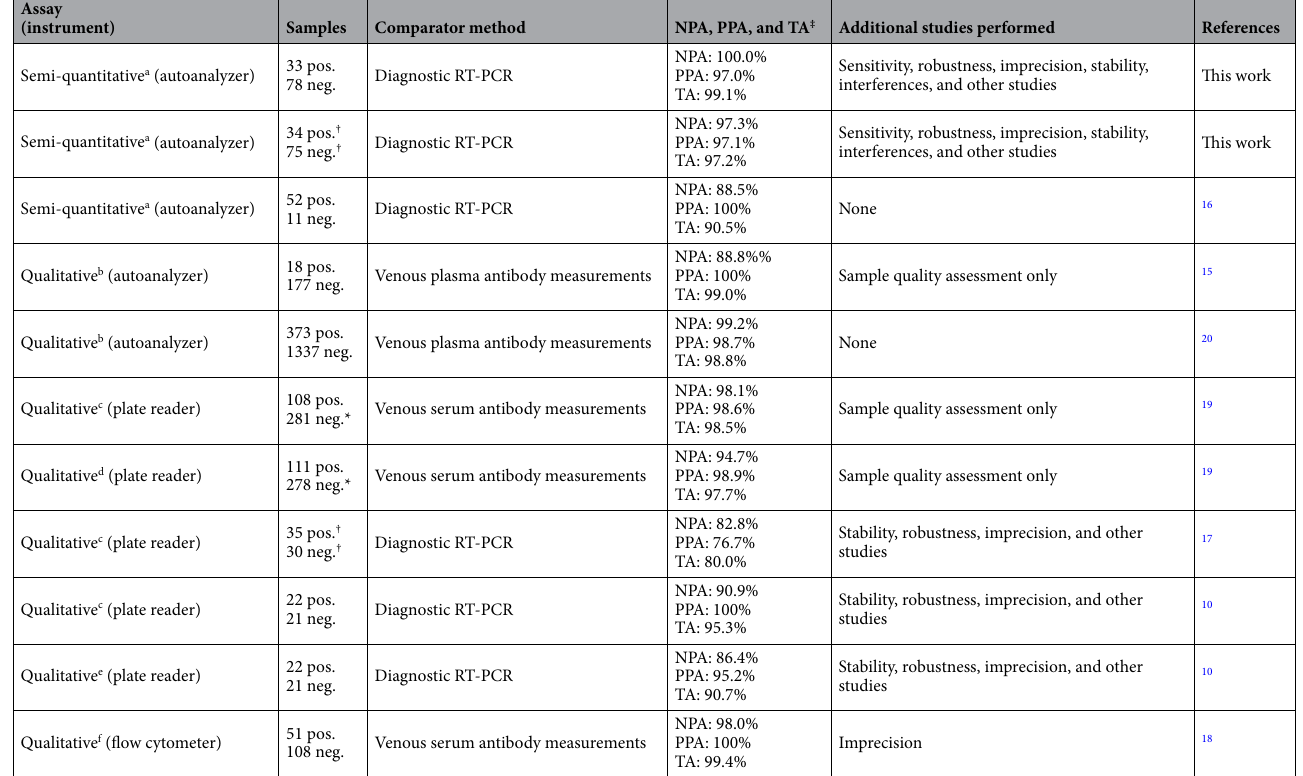
Table 1. Comparison of different DBS studies performed for measurement of SARS-CoV-2 antibodies. *Borderline measurements were treated as negative for ease of method comparison. † DBS samples were self- collected by the patient. ‡ Total agreement. a Roche Elecsys Anti-SARS-CoV-2 S immunoassay. b Roche Elecsys